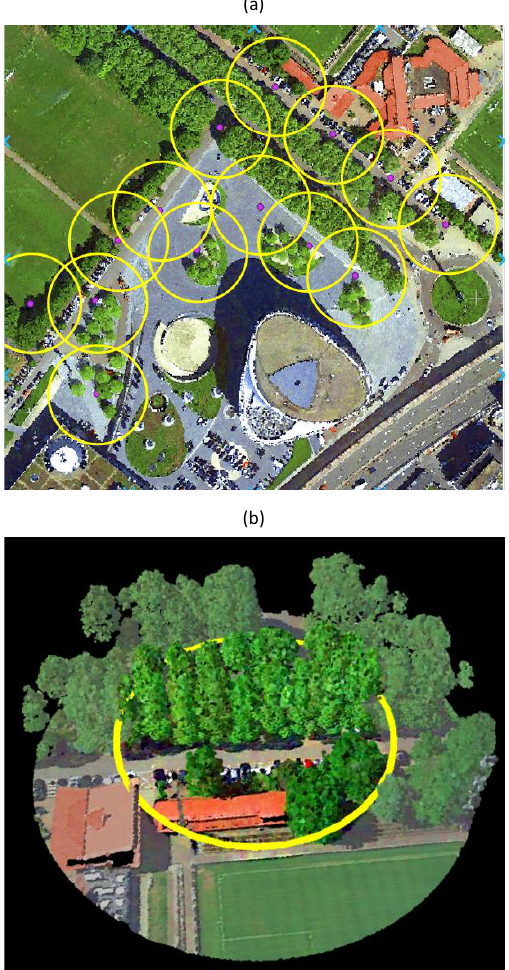
Figure 2. Overview (a) and example of one section (b) of the M3D-dataset